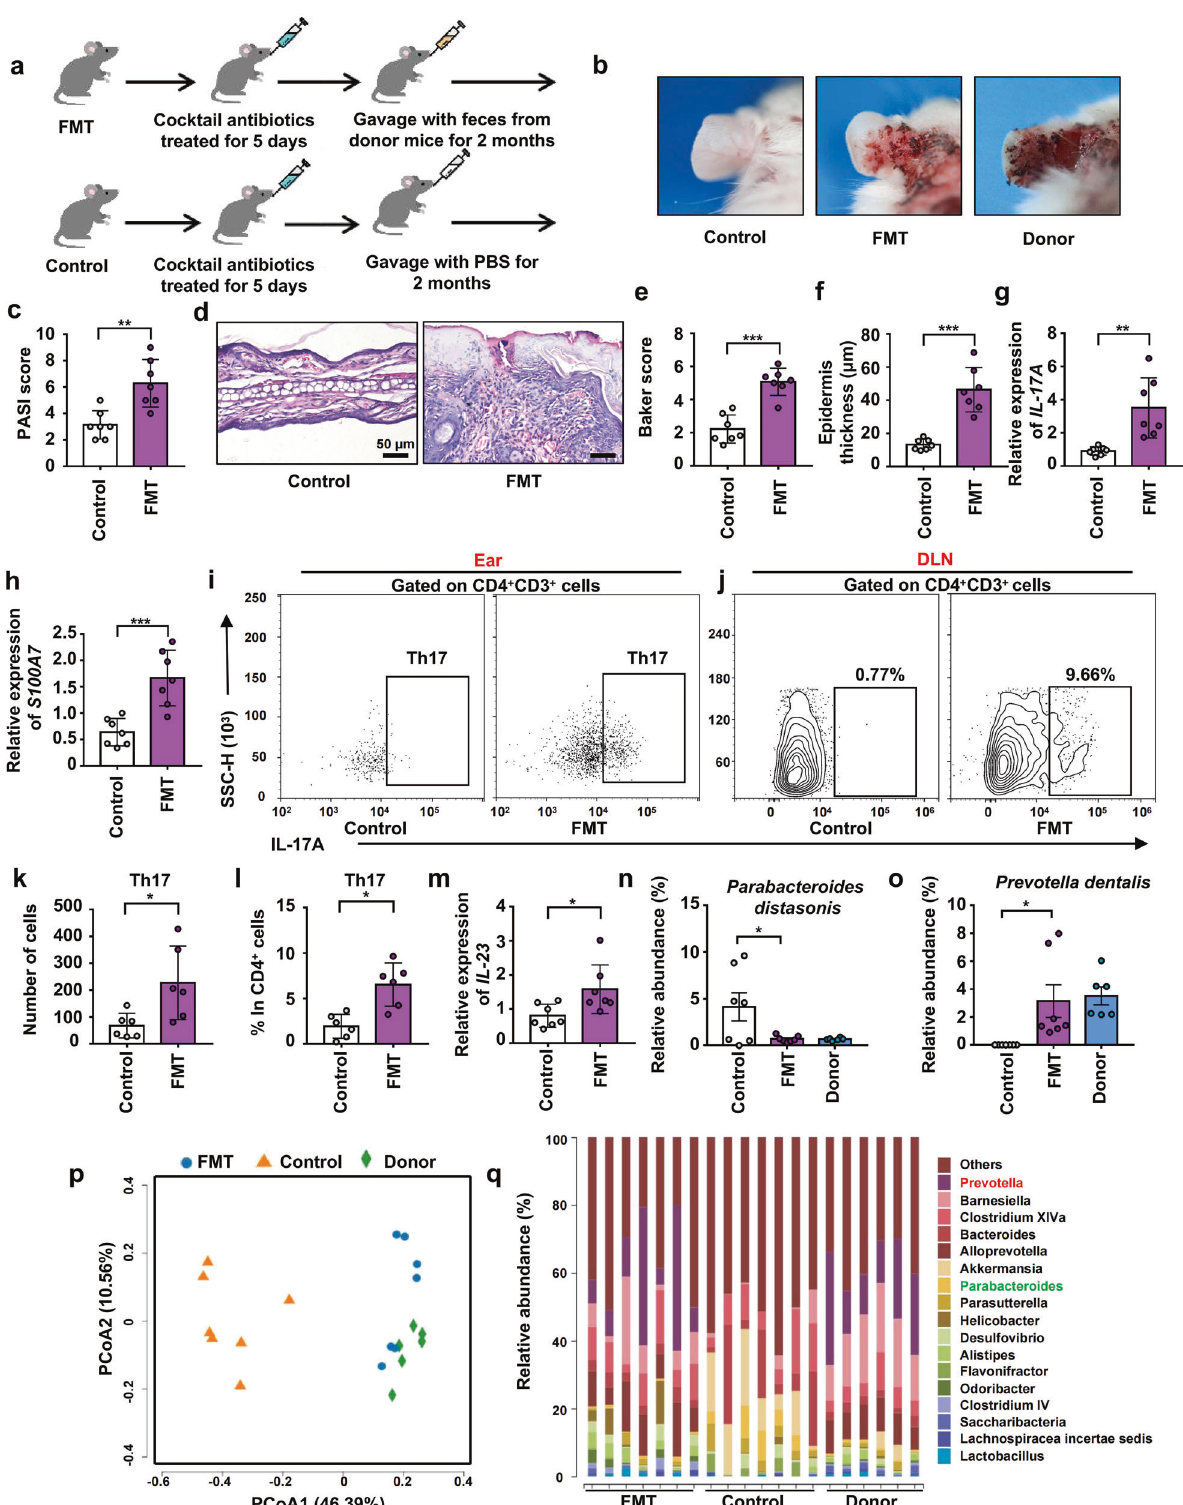
the FMT experiment as previously mentioned. (Supplementary Fig. 4d). The intestinal metabolite composition of transplanted mice was similar to that of donor mice and different from that of control mice (Fig. 5a). A heatmap of metabolites and a volcano plot revealed similar metabolite abundance in FMT and Donor mice (Fig. 5b, c). In addition, similar to the results of the